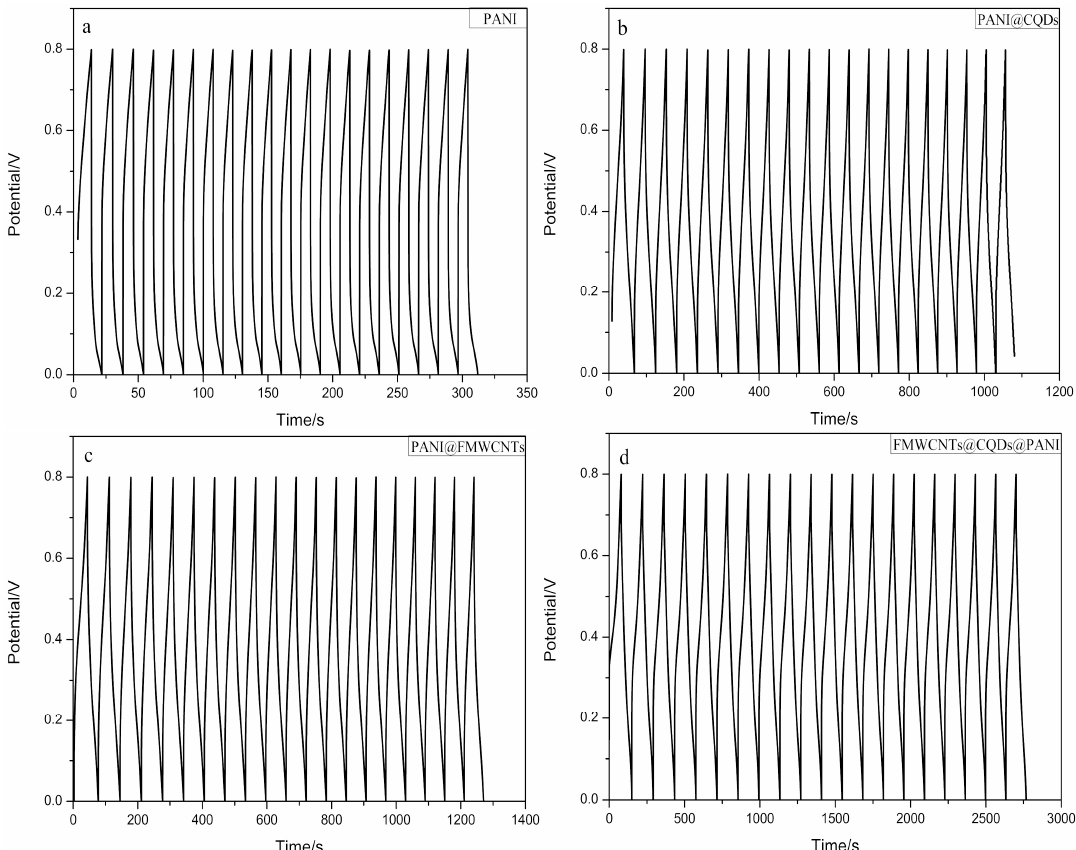
Figure 3. Time curves of ( a ) PANI, ( b ) PANI @ CQDs, ( c ) PANI @ FMWCNTs and ( d ) FMWCNTs @ CQDs @ PANI constant current charge and discharge cycle for 20 periods.